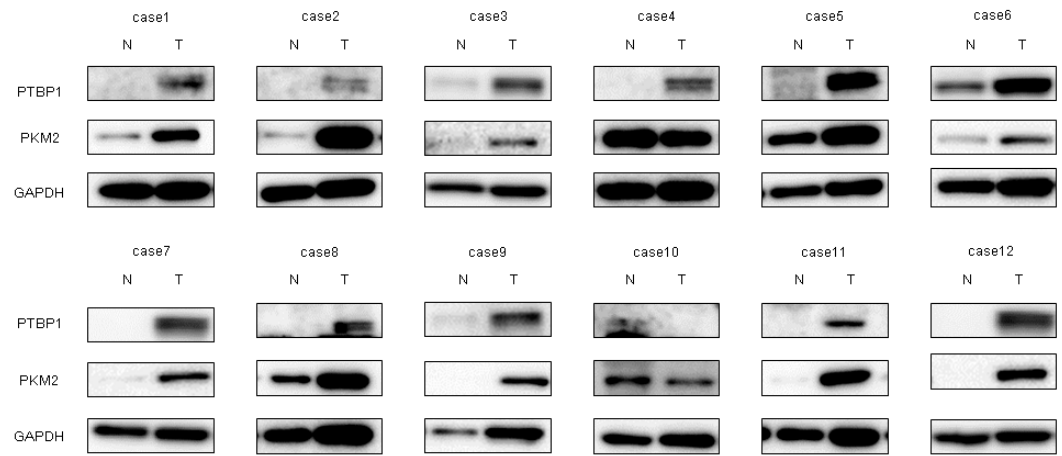
Figure 3. Increased expression levels of polypyrimidine tract-binding protein 1 (PTBP1) and pyruvate kinase muscle isoform 2 (PKM2) were demonstrated in clinical tumor samples from bladder cancer patients. PTBP1 and PKM2 expression in 12 bladder cancer clinical samples as determined by Western blot analysis. Details of the characteristics of the samples are given in Table 1. GAPDH was used as the control.